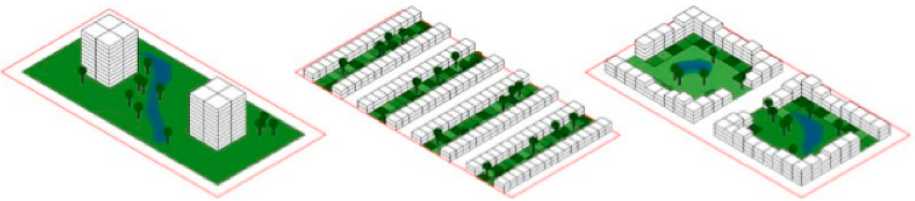
Figure 4. Three urban types (point, street, and perimeter block) with the same density (floor space index = 0.75) display differences in other density measures, as revealed in spacematrix analysis (e.g., ground space index, building height, open space ratio), as well as differences in green space ratio and parcel density (i.e., institutional configuration).